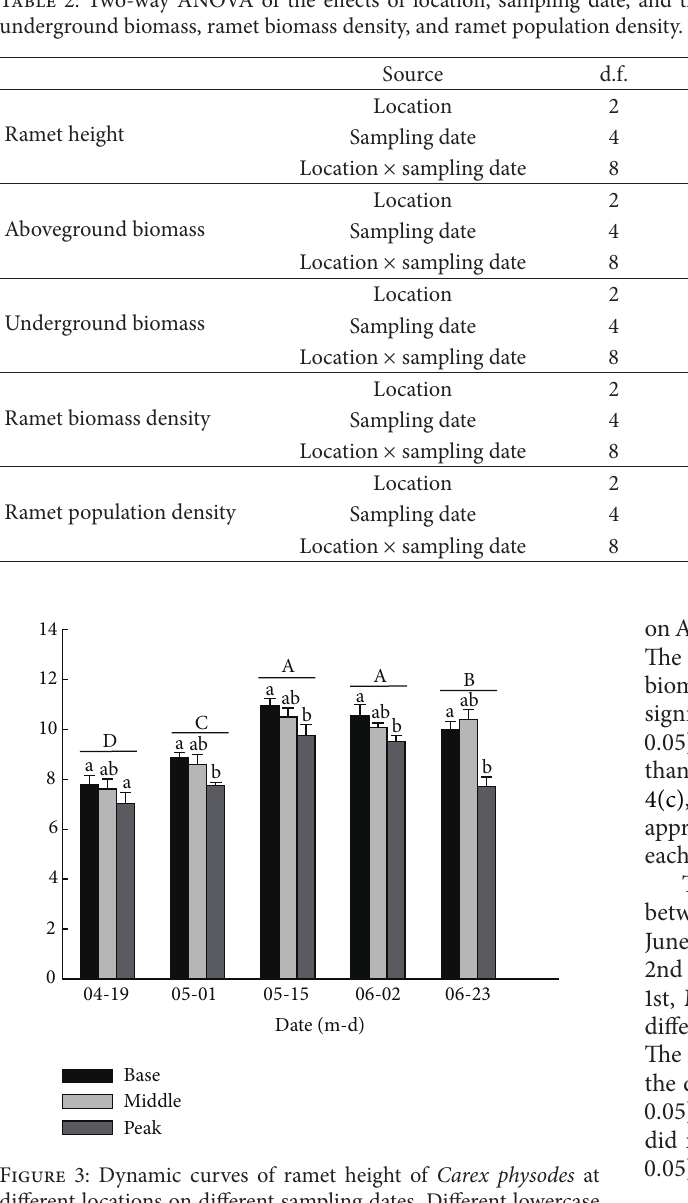
Figure 3: Dynamic curves of ramet height of Carex physodes at different locations on different sampling dates. Different lowercase letters indicate a significant difference of ramet height among three locations at the same sampling date ( 𝑃 < 0.05 ). Different uppercase letters indicate a significant difference among sampling dates at the three locations ( 𝑃 < 0.05